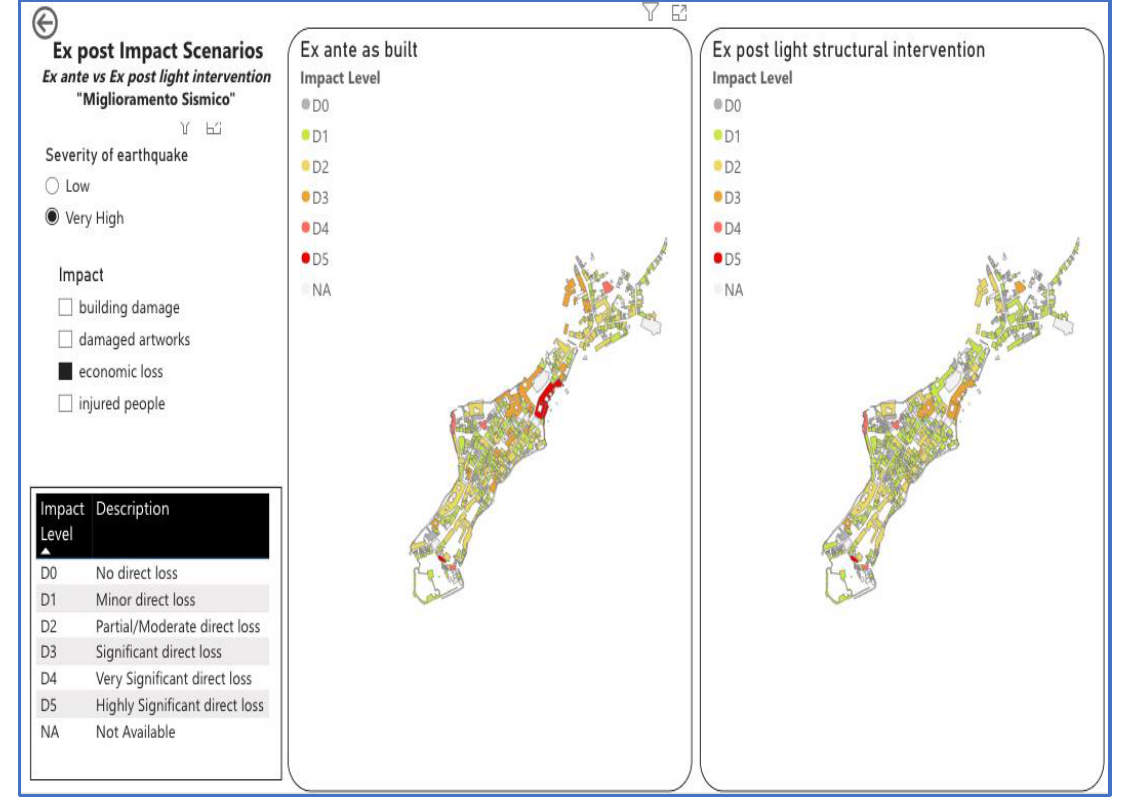
Figure A1. Comparative Visualization of ex ante and ex-post impact scenarios: the effective of implementing a resilience option can be seen and compared with as-built scenarios.